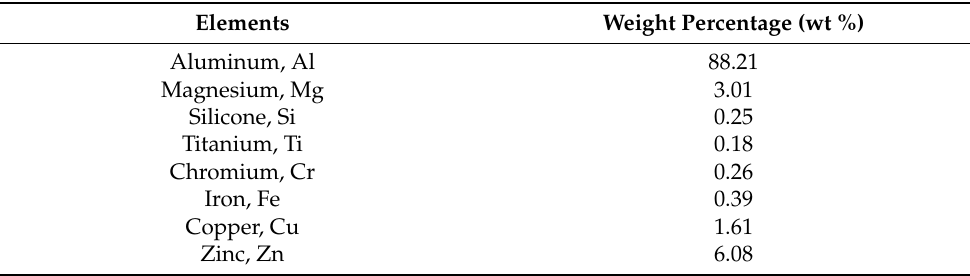
Table 1. The element composition of the as-received AA7075 aluminum matrix.